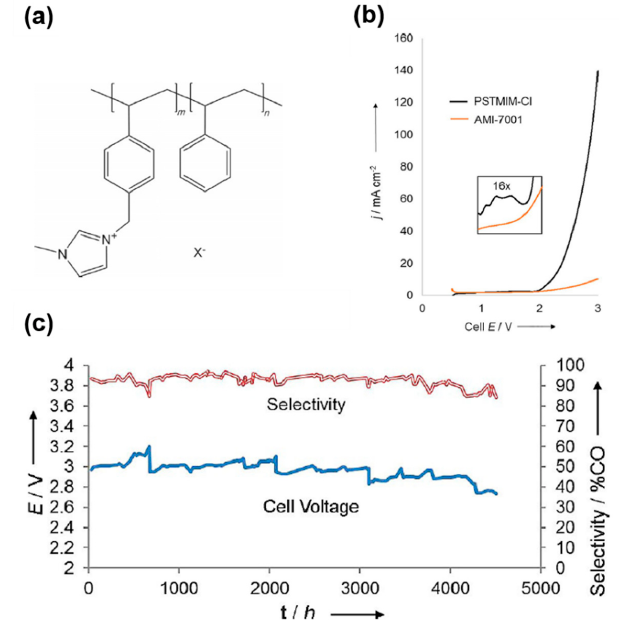
Figure 10. The general characteristics of Sustainion PSTMIM membrane ( a ) chemical structure of the PSMIM membrane. ( b ) Comparison of current density for PSMIM and AMI-7001 membranes. ( c ) The results of a long-term CO 2 reduction test with the PSMIM membrane. Reprinted with permission from the authors of [24].